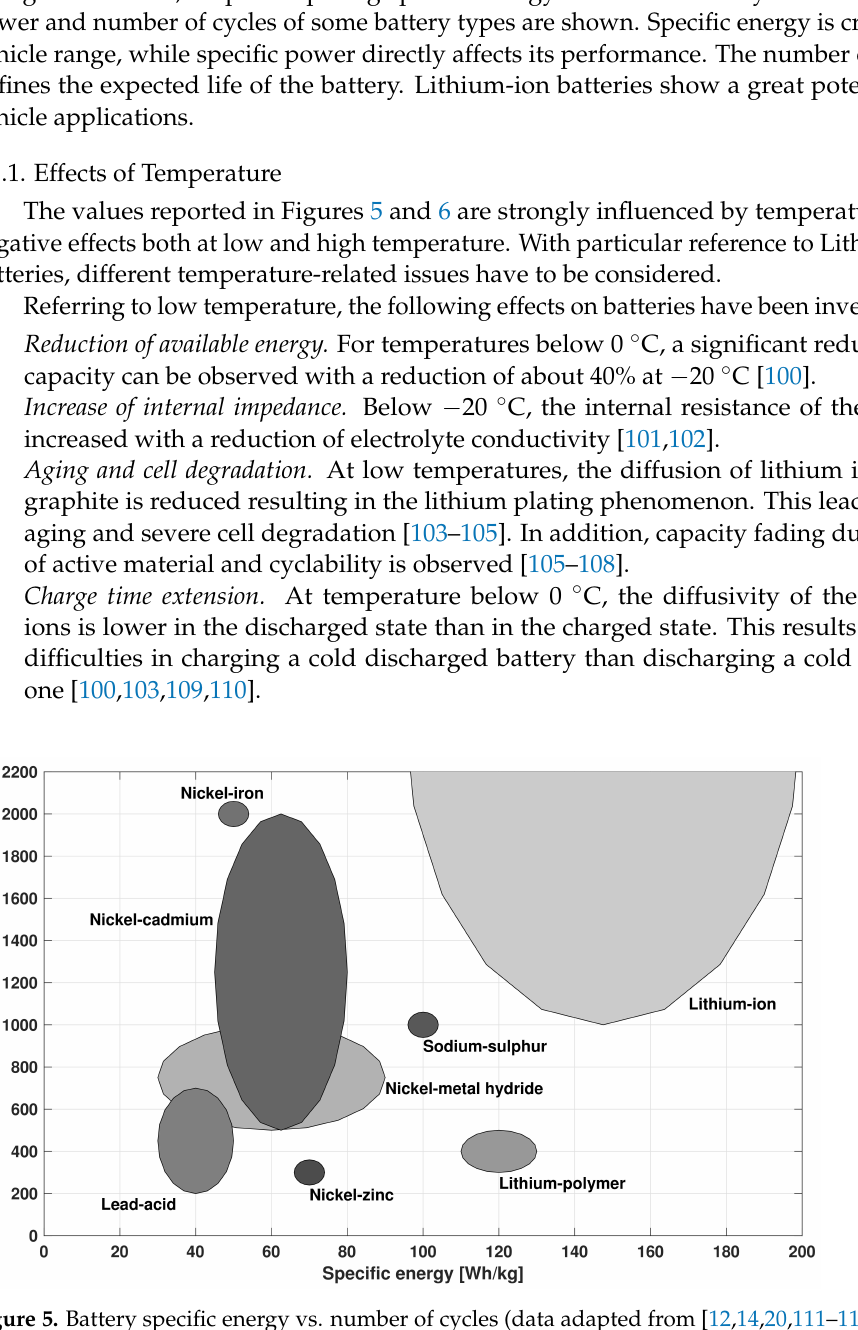
Figure 5. Battery specific energy vs. number of cycles (data adapted from